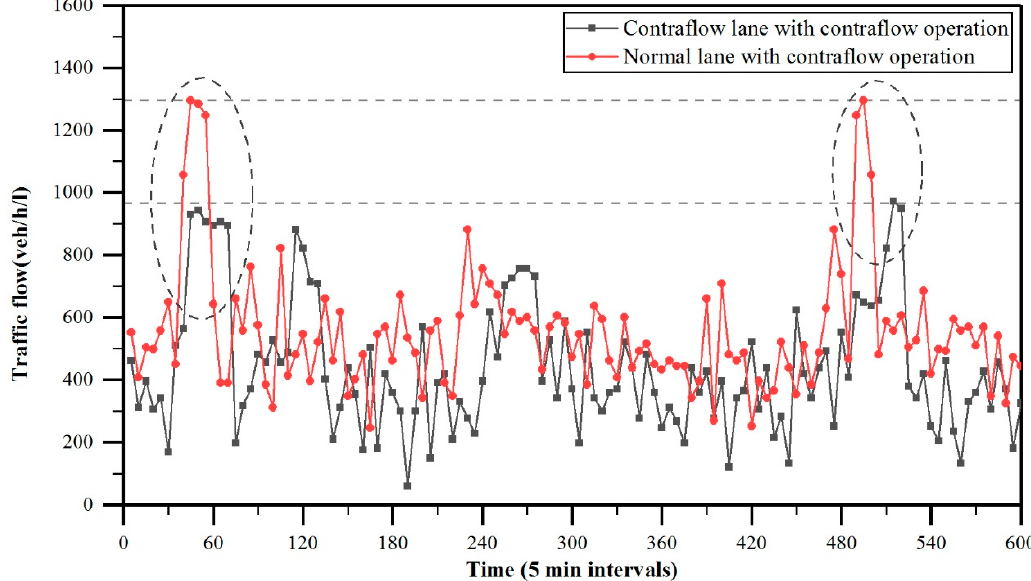
Figure 2. Tra ffi c volumes on the contraflow and normal lanes observed over 5-min Figure 2. Traffic volumes on the contraflow and normal lanes observed over 5 ‐ min intervals.